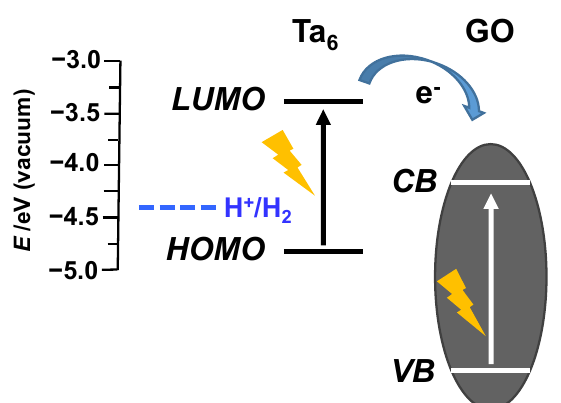
Figure 7. Schematic energy diagram which depicts the electron injection from the LUMO orbitals of [{Ta 6 Br i 12 }(H 2 O) a 6 ] 2+ cluster into the CB of GO.